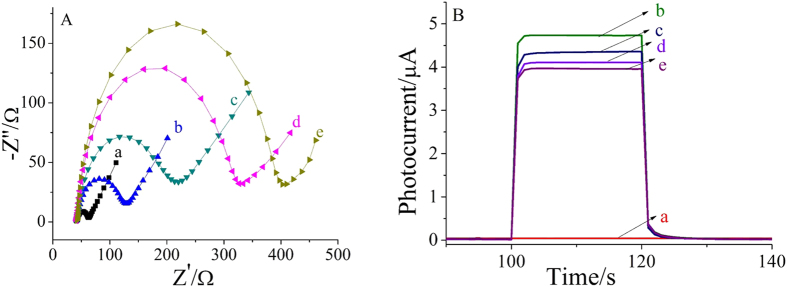
EIS in the presence of 5.0 mmol/L [Fe(CN)6]3−/4− solution containing 0.1 mol/L KCl (A) and photocurrent–time curves in 0.1 mol/L PBS (pH = 7.0) containing 0.1 mmol/L AA with 0.1 V applied potential and 430 nm excitation light. (B) (a) ITO (b) ITO/g-C3N4/TiO2 composite (c) ITO/g-C3N4/TiO2/Anti-CEA (d) ITO/g-C3N4/TiO2/Anti-CEA/BSA (e) ITO/g-C3N4 /TiO2/Anti-CEA/BSA/CEA.